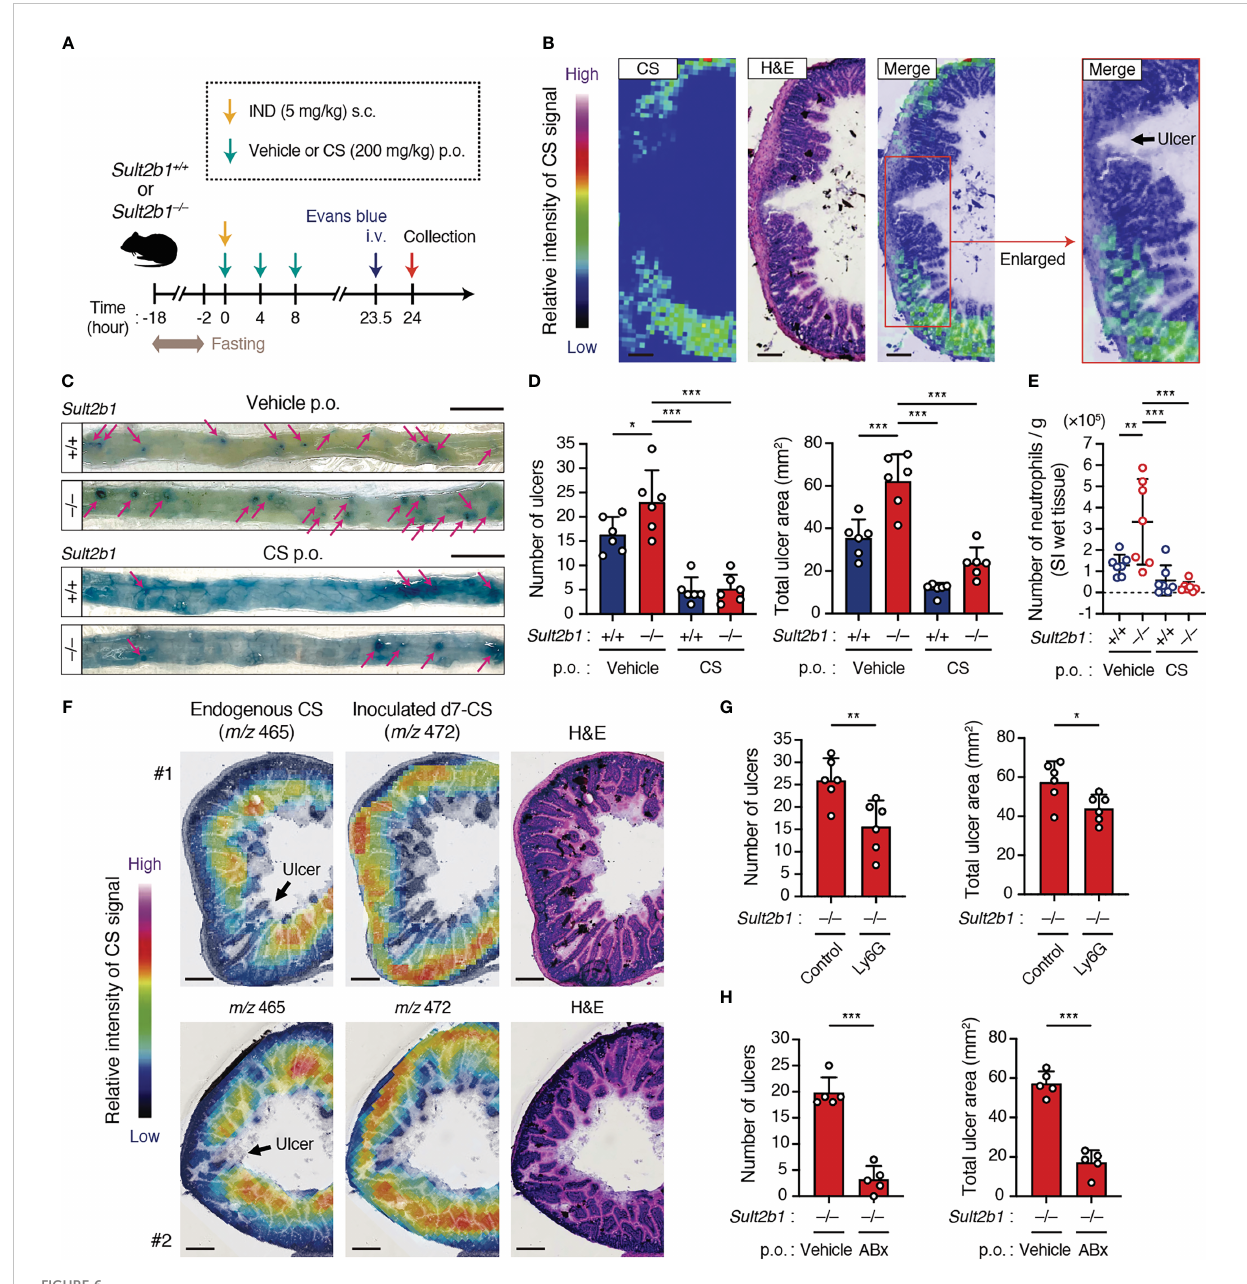
FIGURE 6 CS ameliorates IND-induced ulcers in the SI. (A) Schematic illustration of the protocol used for the IND-induced ulcer model and CS treatment. Vehicle or CS was orally administrated to mice three times at 4-hour intervals. (B) Localization of CS in the cross-section of the SI from IND-treated Sult2b1 +/+ mice visualized using MS imaging and H&E staining. The color bar indicates the relative intensities of the CS signal. The enlarged (boxed) area is shown on the right. Scale bar, 200 m m. (C) Representative macroscopic images of IND-induced SI ulcers in Sult2b1 +/+ and Sult2b1 − / − mice after vehicle or CS administration. Ulcerative lesions (magenta arrows) are recognized as blue spots in the SI. Scale bar, 10 mm. (D) The number of ulcers (left) and total ulcer area (right) in the SI of Sult2b1 +/+ and Sult2b1 − / − mice after IND injection and CS administration (n = 6 mice per group; one-way ANOVA with Dunnett ’ s multiple comparison test). (E) The absolute number of CD45 + CD11b + Gr-1 + neutrophils per 100-mg SI (wet tissue) of Sult2b1 +/+ and Sult2b1 − / − mice after IND injection and CS administration (n = 7 mice per group; one-way ANOVA with Dunnett ’ s multiple comparison test). (F) Localization of endogenous CS ( m/z 465) and inoculated d7-CS ( m/z 472) in the cross-section of the SI from IND-treated Sult2b1 +/+ mice visualized using MS imaging and H&E staining. The color bar indicates the relative intensities of the CS signal. Scale bar, 200 m m. (G, H) The number of ulcers (left) and total ulcer area (right) in the SI of IND-treated Sult2b1 − / − mice (n = 5 mice per group; two-tailed unpaired Student ’ s t -test). Before IND injection, anti-Ly6G or isotype control antibodies were intraperitoneally administrated (G) , and a vehicle or a mixture of ABx was orally administered to the mice (H) . Data were obtained from two (B, F, G) and three (C – E, H) independent experiments, and graphs are shown as the mean ± SD. * P < 0.05; ** P < 0.01; *** P <